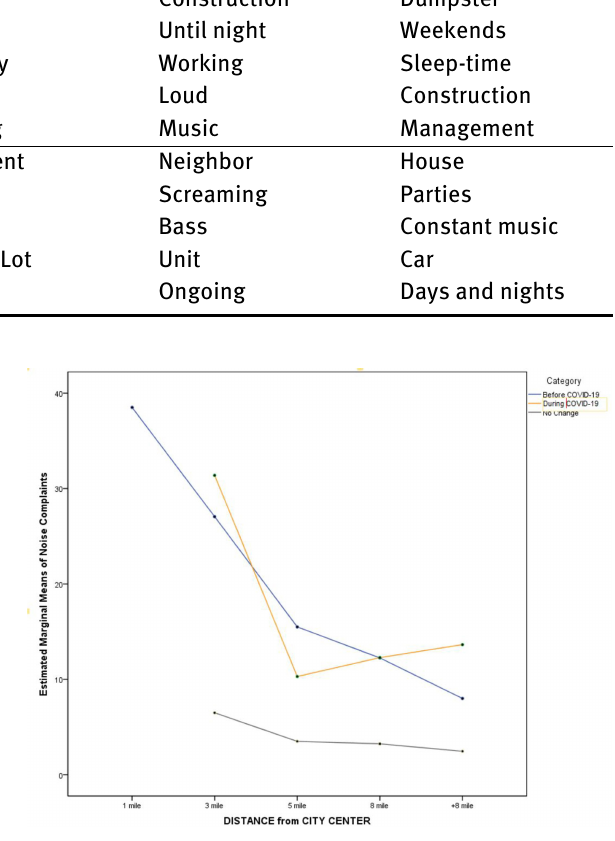
Figure 5: Estimated marginal means and distance from city center among period